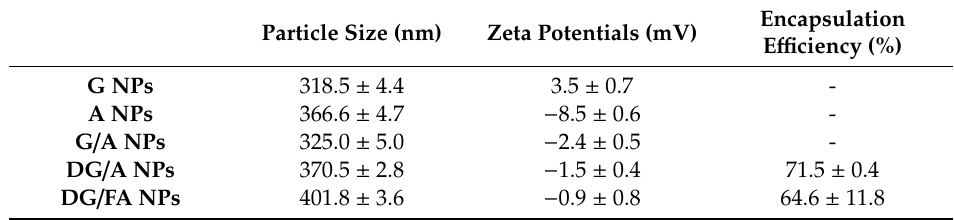
Table 1. The particle size, zeta potential, and encapsulated rate of gelatin nanoparticles (G NPs), alginate nanoparticles (A NPs), gelatin / alginate nanoparticles (G / A NPs), doxorubicin (DOX)–gelatin / alginate nanoparticles (DG / A NPs), and DOX–gelatin / Fe 3 O 4 –alginate nanoparticles (DG / FA